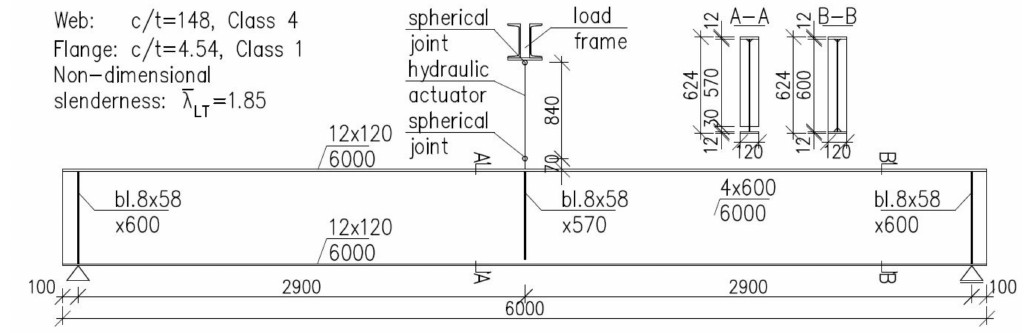
Figure 2. Schematic view of the tested beam. Width to thickness ratio for the element (c/t) and non-dimensional slenderness according to